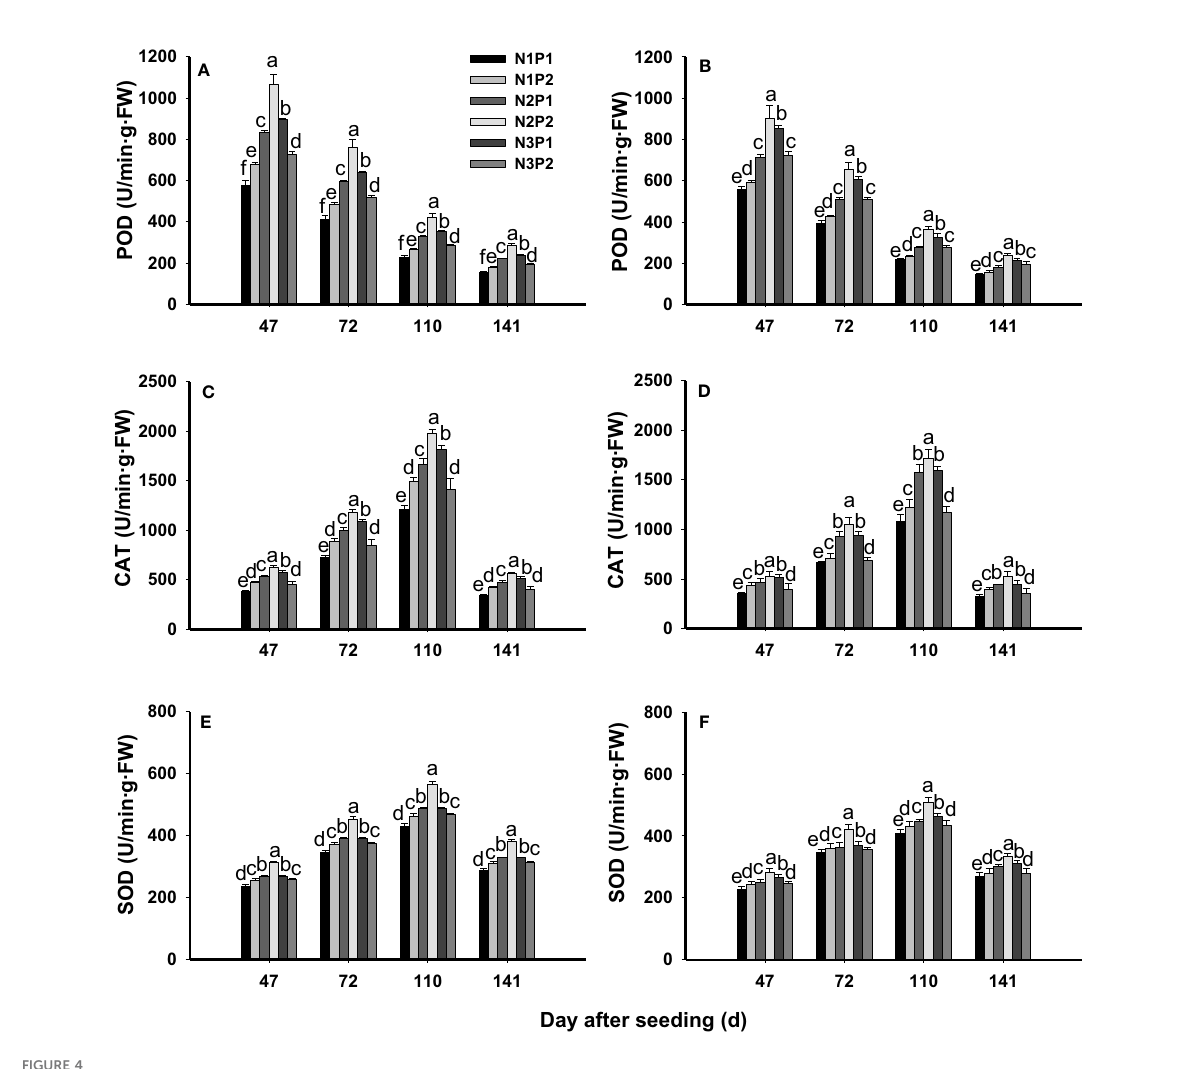
FIGURE 4 Effects of different nitrogen and phosphorus combinations on activities of peroxidase (POD), catalase (CAT) and superoxide dismutase (SOD) of sesbania pea at different growth stages. Different letters indicate signi fi cant differences between different treatments at same growth stage at P<0.05 level. (A, C, E) : 2020; (B, D, F) :